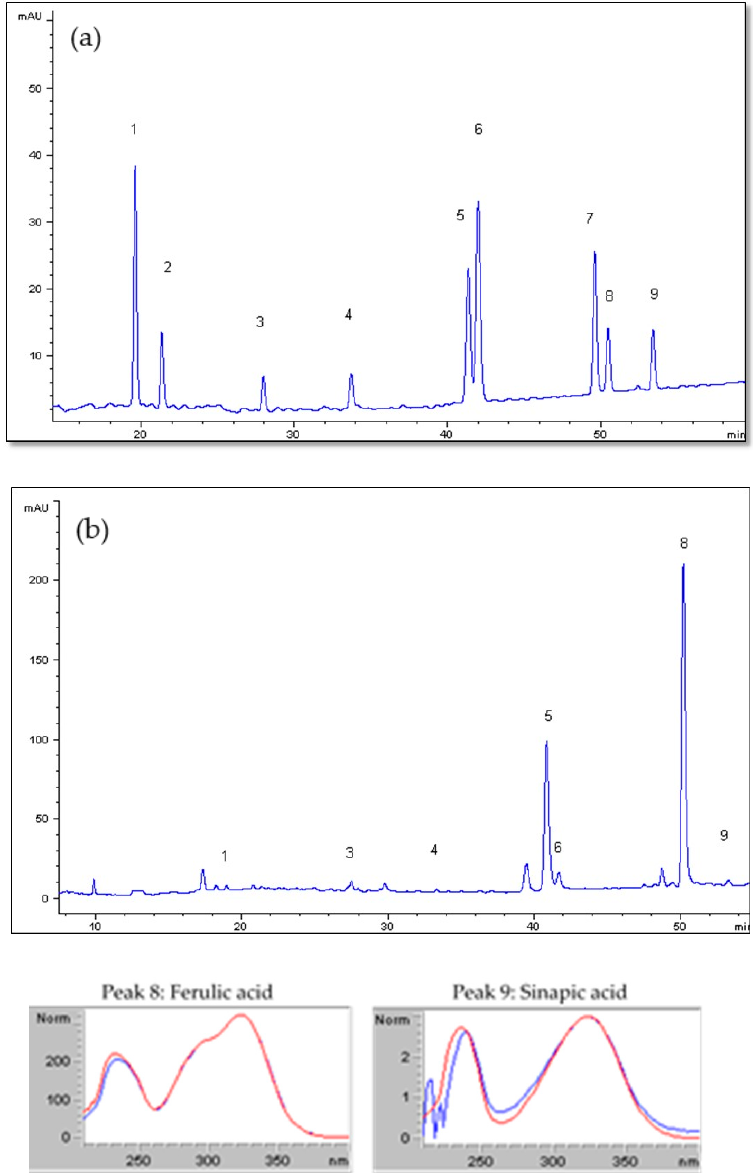
Figure 6 Figure 6. HPLC / DAD chromatograms at 280 nm of individual phenolic standards ( a ) and